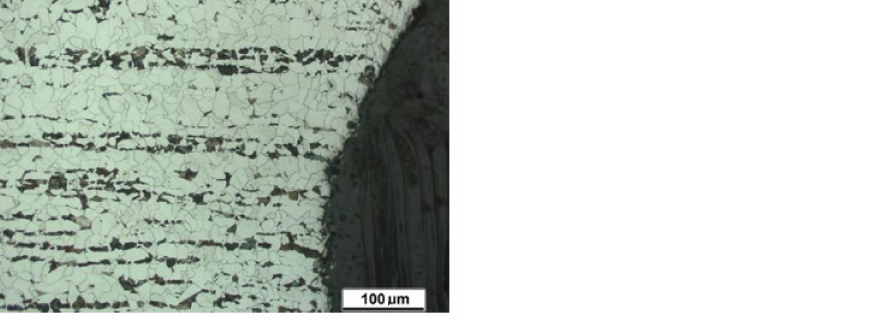
Figure 8. Microstructure of the welded specimen after normalizing annealing, ferrite with a small amount of pearlite.